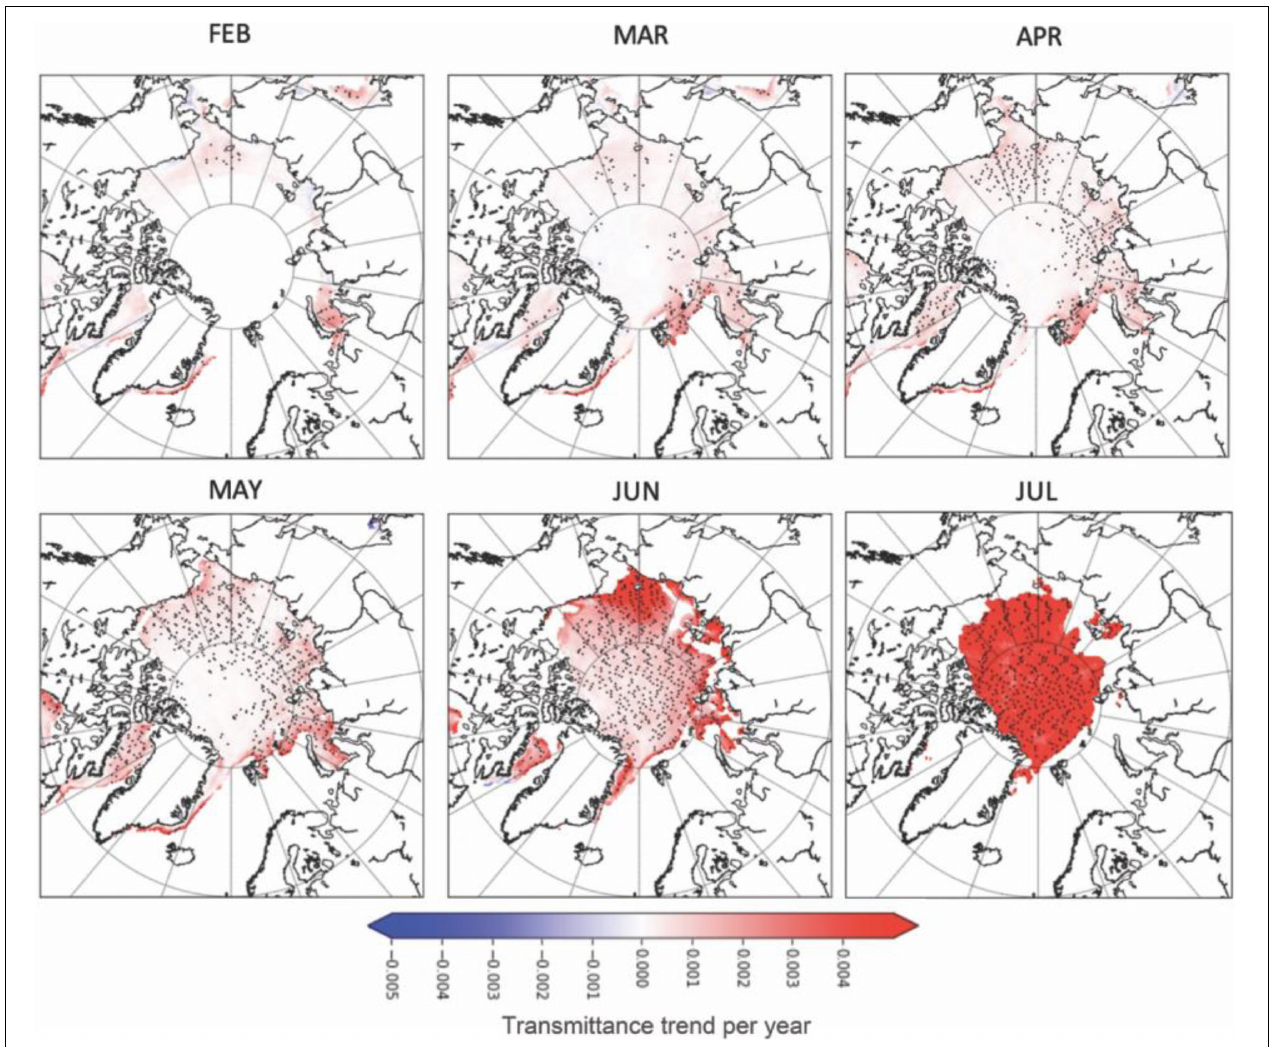
FIGURE 15 | Under-snow transmittance trends per year computed using the albedo and snow depth in February through July from 1982 to 2018 over Arctic sea ice. Trends statistically significant at the 95% confidence level are indicated by black